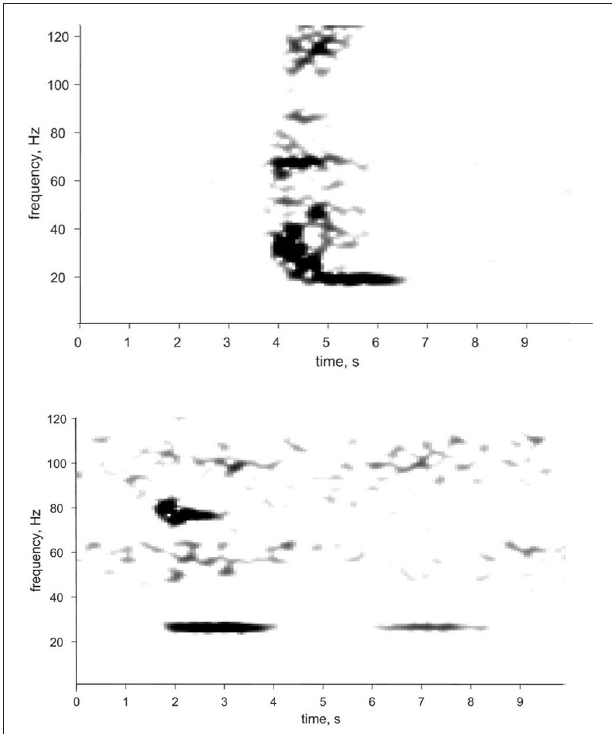
FIGURE 1 | Spectrogram and time series of two calls attributed to Bryde’s whales in the eastern tropical Pacific. The 18Hz low-burst tonal (top) and 25Hz high burst tonal (bottom) calls are described in Heimlich et al. (2004) and are very similar to the Be2 calls described in Oleson et al. (2003). Spectrogram parameters: 0.512-s (128-sample) frame size, 1.024-s (256 sample) FFT size, 87.5% overlap, and Hanning window, for a filter bandwidth of